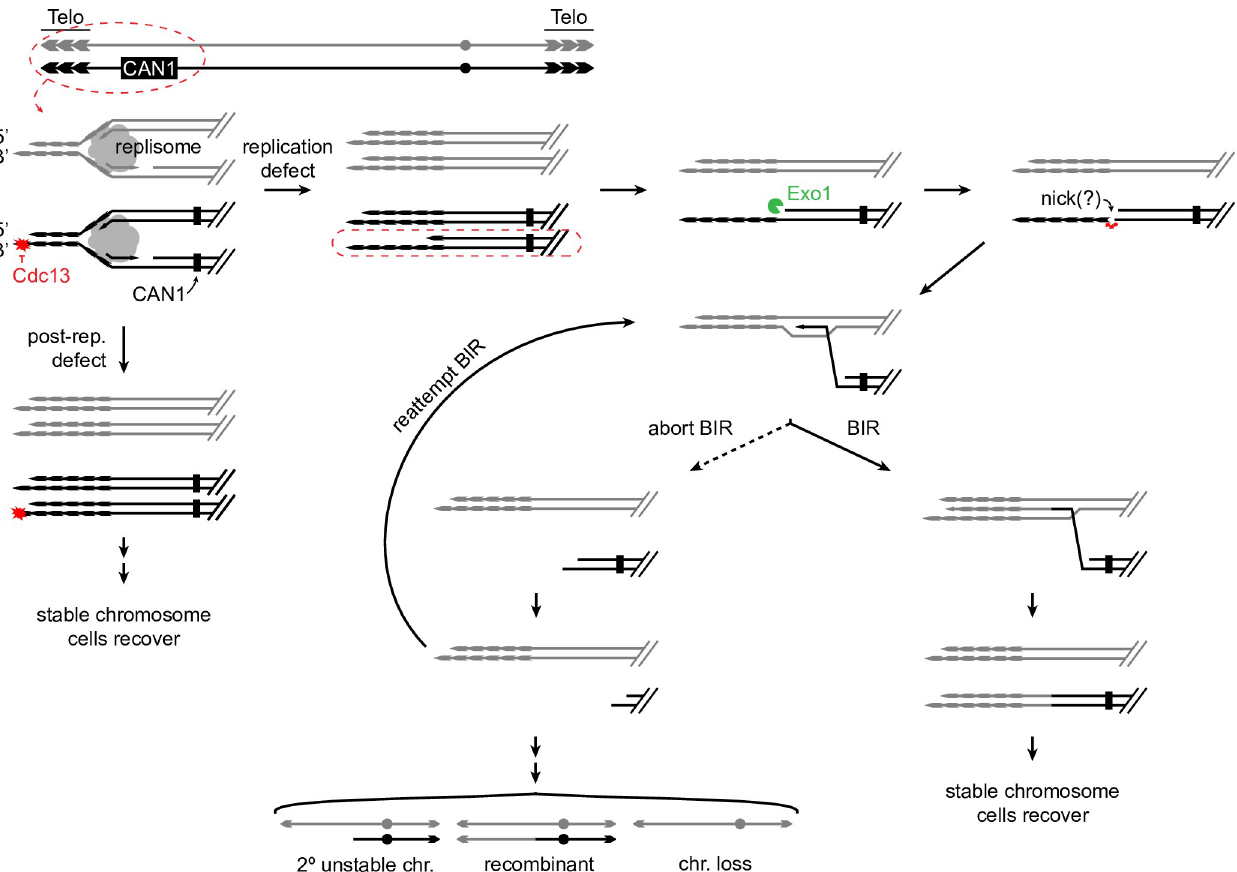
Fig 7. Model for formation of unstable chromosomes in the telomere. A Cdc13 defect leads to a defect in replication of one homolog. The defect leads to extensive ssDNA of the lagging strand template sister, and a complete leading strand template sister. The lagging strand template is nicked and acts as the parental primer strand, which invades an intact homolog in single copy sequence. Two outcomes are possible: replication to the end of the chromosome or re-initiation of BIR. BIR may again abort, in which case the parental primer 3’ may shorten, invade the homolog, and attempt replication